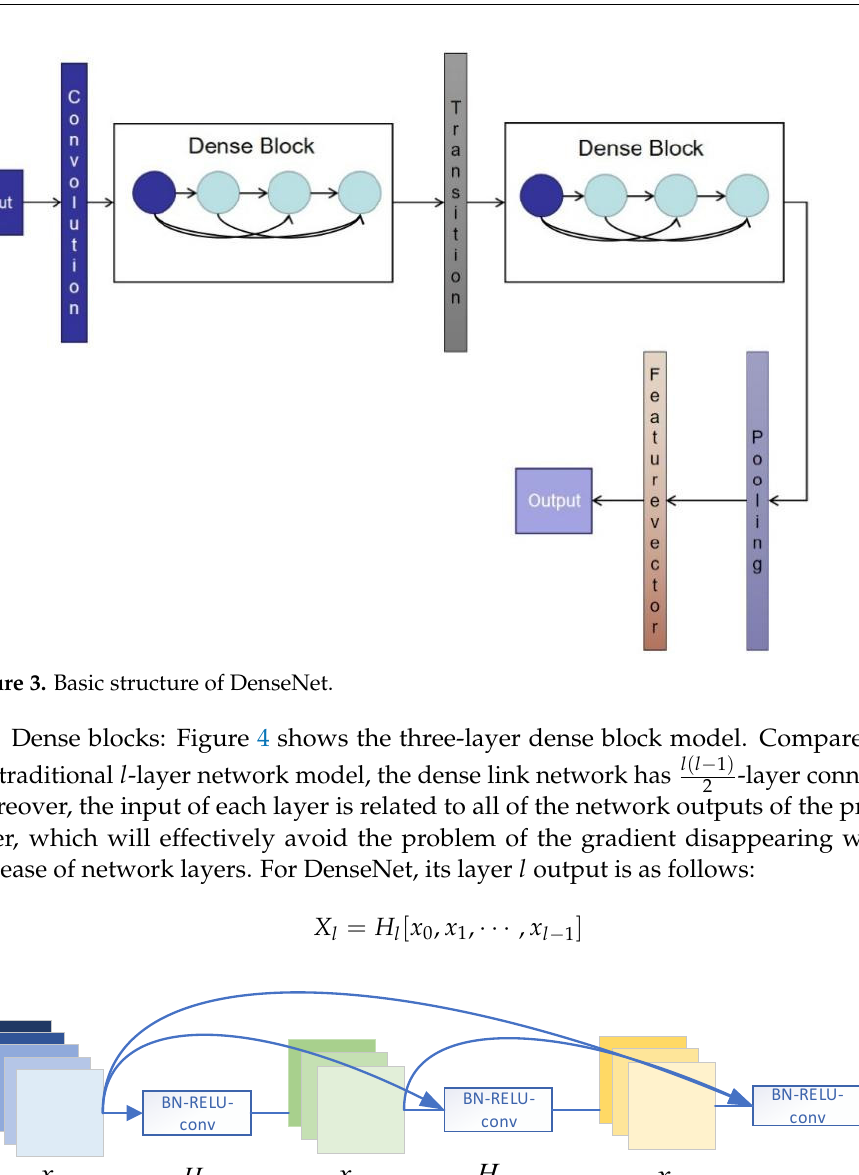
6 of 14 Figure 2. Schematic diagram of the mine MIMO depth receiver model. 3.1. Densely Connected Convolutional Networks The mine MIMO depth receiver is built by means of a densely connected convolu- tional network (DenseNet). DenseNet was proposed by Huang and his colleagues [20]. The network is a unique convolutional neural network where each layer in the network is connected to other layers, and each layer of the network receives the output information from all previous layers. The features extracted from this layer are passed to the subse- quent layers, ensuring that the maximum information flow is obtained between the layers. DenseNet has the advantage of feature reuse and enhanced transfer of feature values com- pared to other convolutional neural network (CNN) structures, and in addition, DenseNet can effectively mitigate the problem of gradient disappearance. The DenseNet network is shown in Figure 3. The DenseNet network is mainly composed of dense blocks and tran- sition layers. Dense blocks: Figure 4 shows the three-layer dense block model. Compared with the traditional l -layer network model, the dense link network has ( 1) 2 l l 